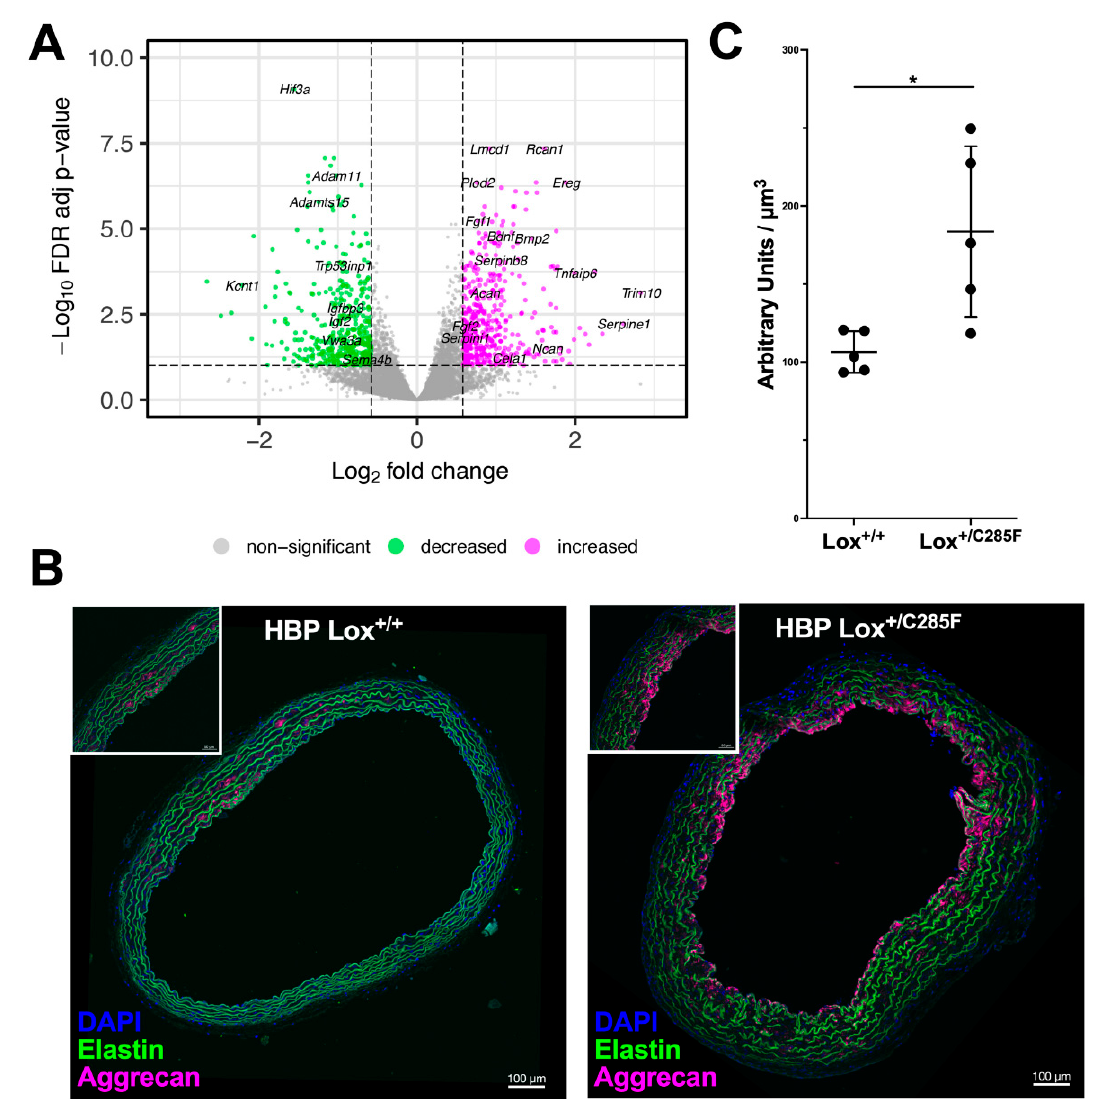
Figure 9. Gene expression pattern reveals increased matrix remodeling in Lox +/C285F mice. ( A ), Volcano plot showing differentially expressed genes in Lox +/+ vs. Lox +/C285F aortas ( n = 4/group). Positive Log2 denotes higher expression in Lox +/C285F . ( B ), Anti − aggrecan antibody staining in 6-month HBP aortas demonstrated increasing deposition of aggrecan in Lox +/C285F . Representative images, n = 5/group. Note the asymmetric appearance of the aggrecan staining. ( C ), Quantification of aggrecan represented as total fluorescence of the intensities (arbitrary units) per each μ m 3 of aortic wall volume in Lox +/+ vs. Lox +/C285F aortas, n = 5/group. *, p < 0.05 (Paired t -test).